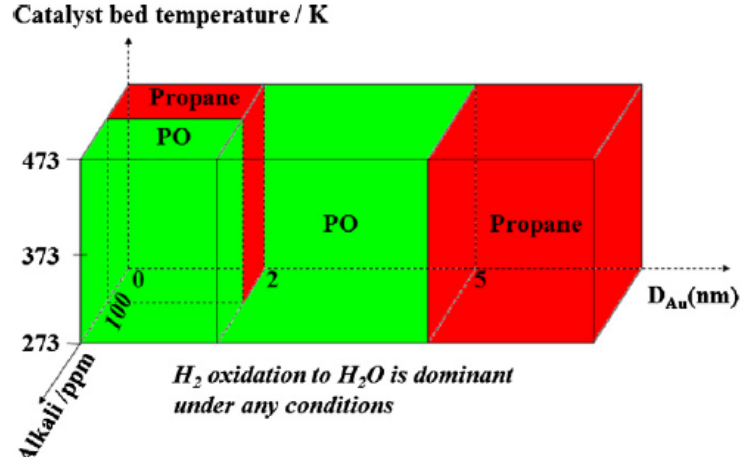
Figure 1. The role of factors in deciding between the hydrogenation and epoxidation of propene. Reproduced with permission from Reference [10]. Copyright (2011)